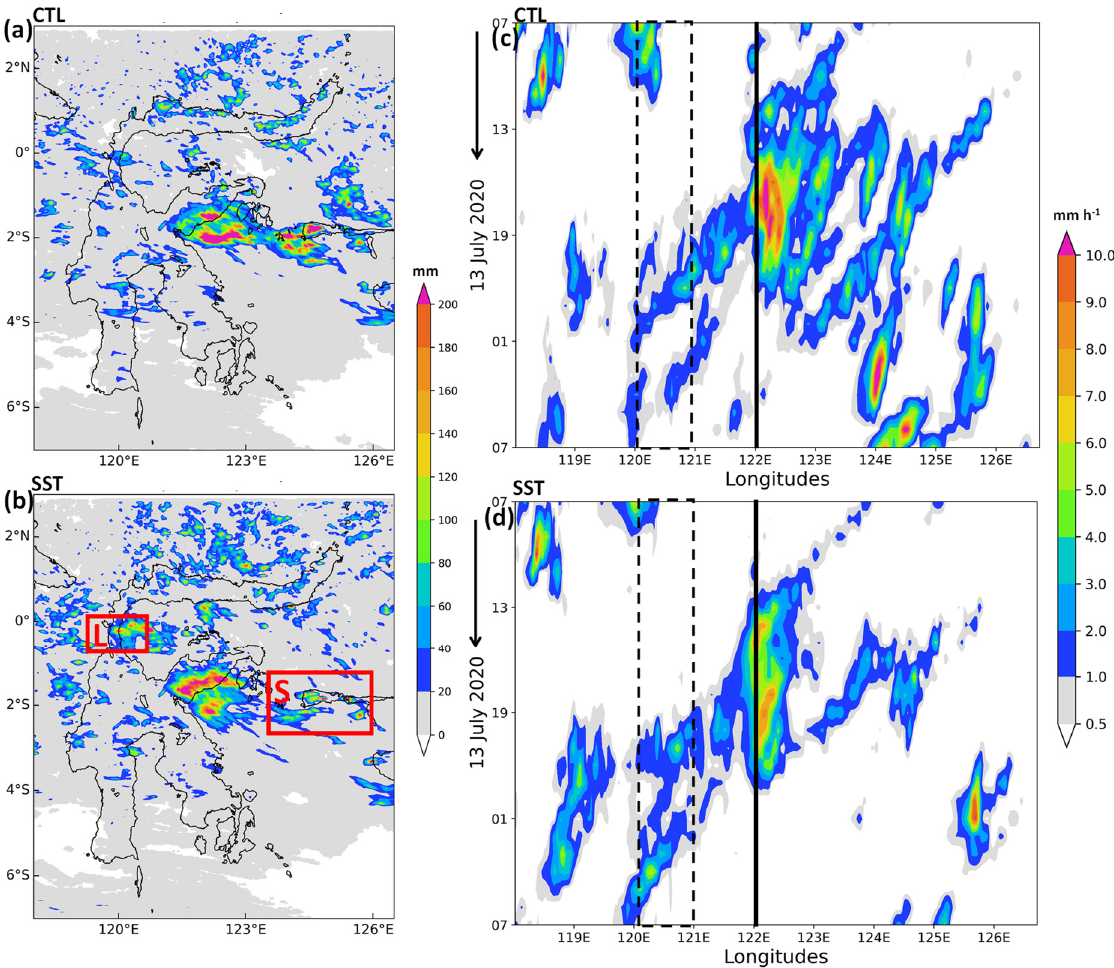
Figure 5. ( a , b ) Same as Figure 4b, but for simulated precipitation in the CTL and updated SST runs, respectively. ( c , d ) Same as Figure 4d, but for simulated precipitation in the CTL and updated SST runs, respectively. The red solid boxes of L (1° S–Eq; 119 ° –121° E) and S (3° S–1° S; 124° E–126° E) were used for further analysis in Figure 6. The black dashed boxes represent the Luwu region, whereas the vertical solid line denotes the east coastal line of central Sulawesi.